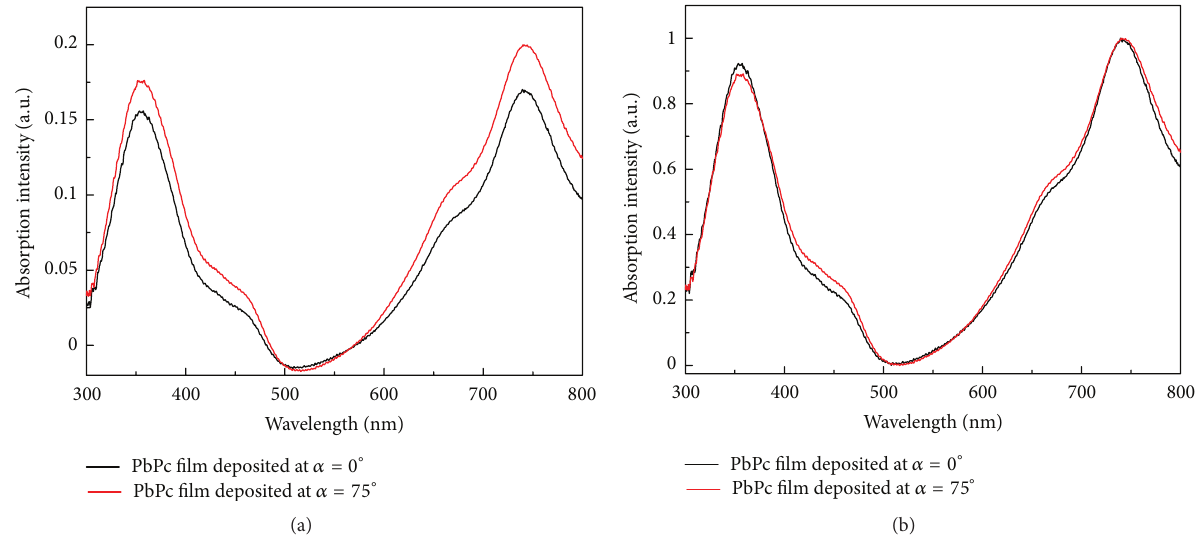
Figure 2: (a) The absorption spectra of PbPc films prepared by normal conditions and glancing angle deposition at 75 ∘ , (b) the normalized absorption